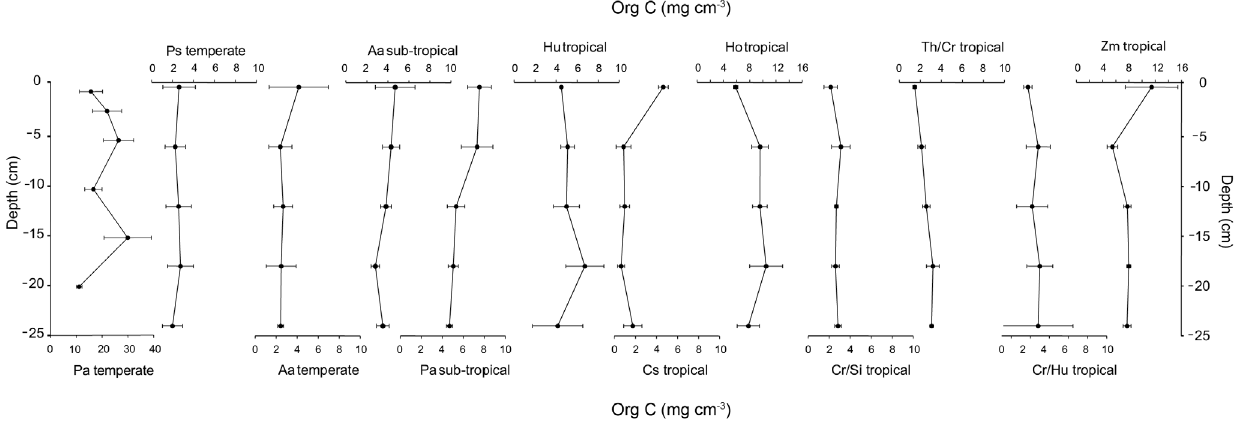
Figure 2. Profiles of organic carbon stocks in the top 25 cm of cores from different Australian seagrass meadows. All data are means 6 std